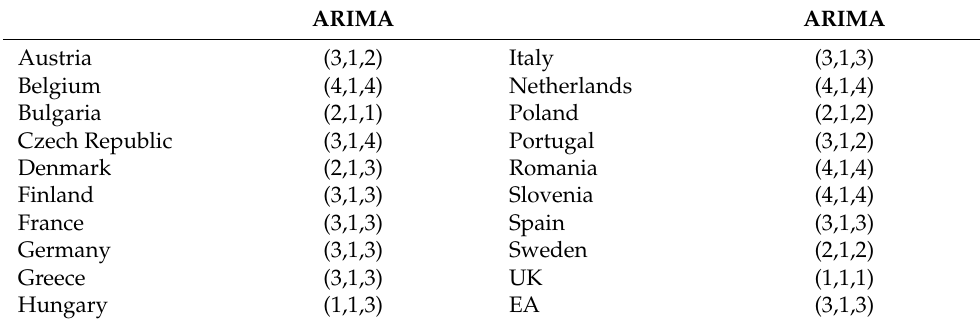
Table A3. Selected ARIMA